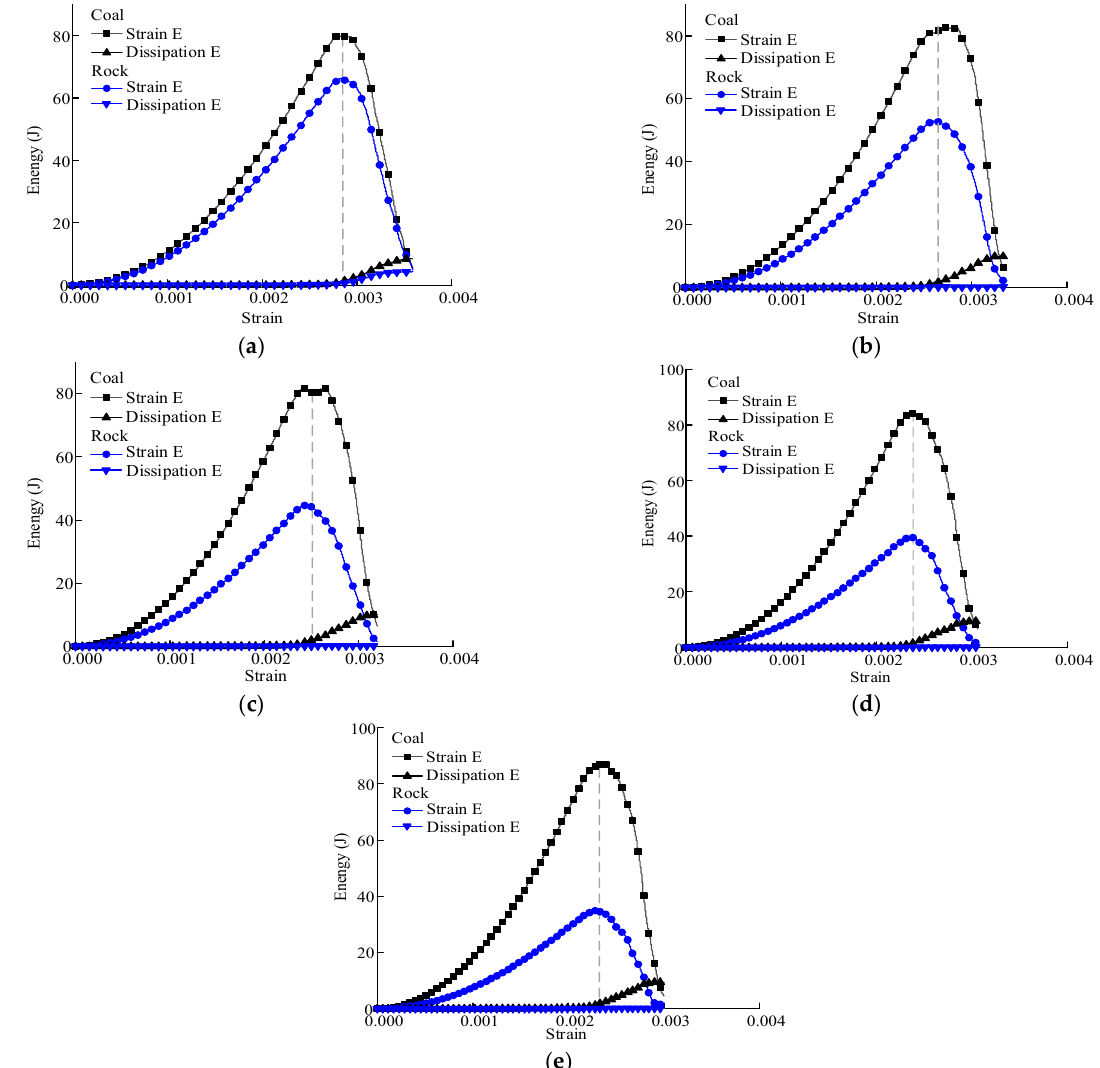
Figure 7. Partition energy evolution law of combinations. ( a ) Combination 1-1. ( b ) Combination 1-2. ( c ) Combination 1-3. ( d ) Combination 1-4. ( e ) Combination 1-5.